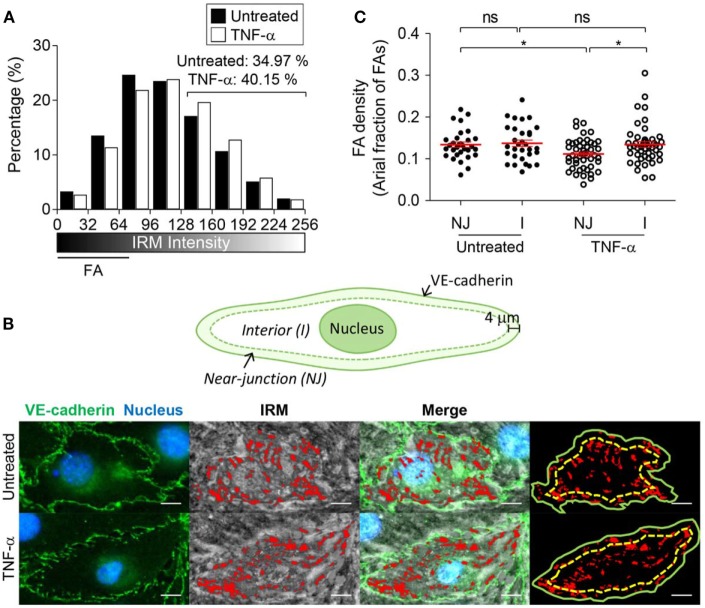
The effect of tumor necrosis factor-α (TNF-α) treatment on EC basal membrane adhesion and FA distribution. (A) IRM image intensity distributions of TNF-α untreated and treated EC monolayer (two-sample Kolmogorov–Smirnov test, p < 0.0001). (B) Definition of near-junction (NJ) and interior (I) regions (top panel), and identification of NJ-FA and I-FA using merged images of VE-cadherin IFM and IRM images (bottom panel). (C) EC-FA density in NJ or interior (I) regions in the presence or absence of TNF-α treatment (Mann–Whitney U-test, *p < 0.05, ns, not significant).